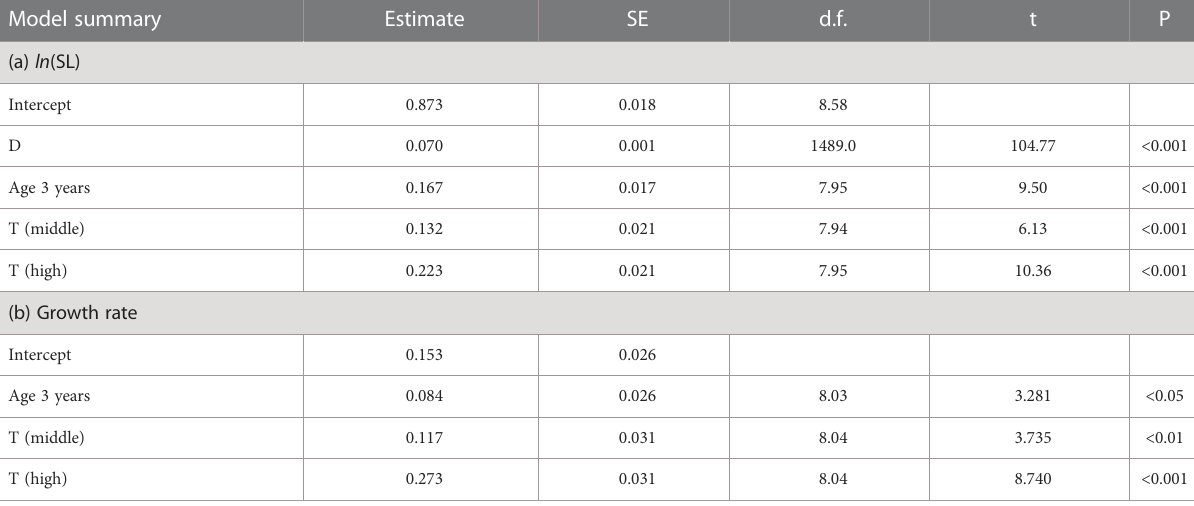
TABLE 6 Summary table for linear mixed effects model estimates fi tted using restricted maximum likelihood for the effect of maternal age (1 versus 3 years) and temperature (low, middle, and high temperature treatments) on the SL – days after hatching (D) relationship and growth rate of chub mackerel larvae by 10 days